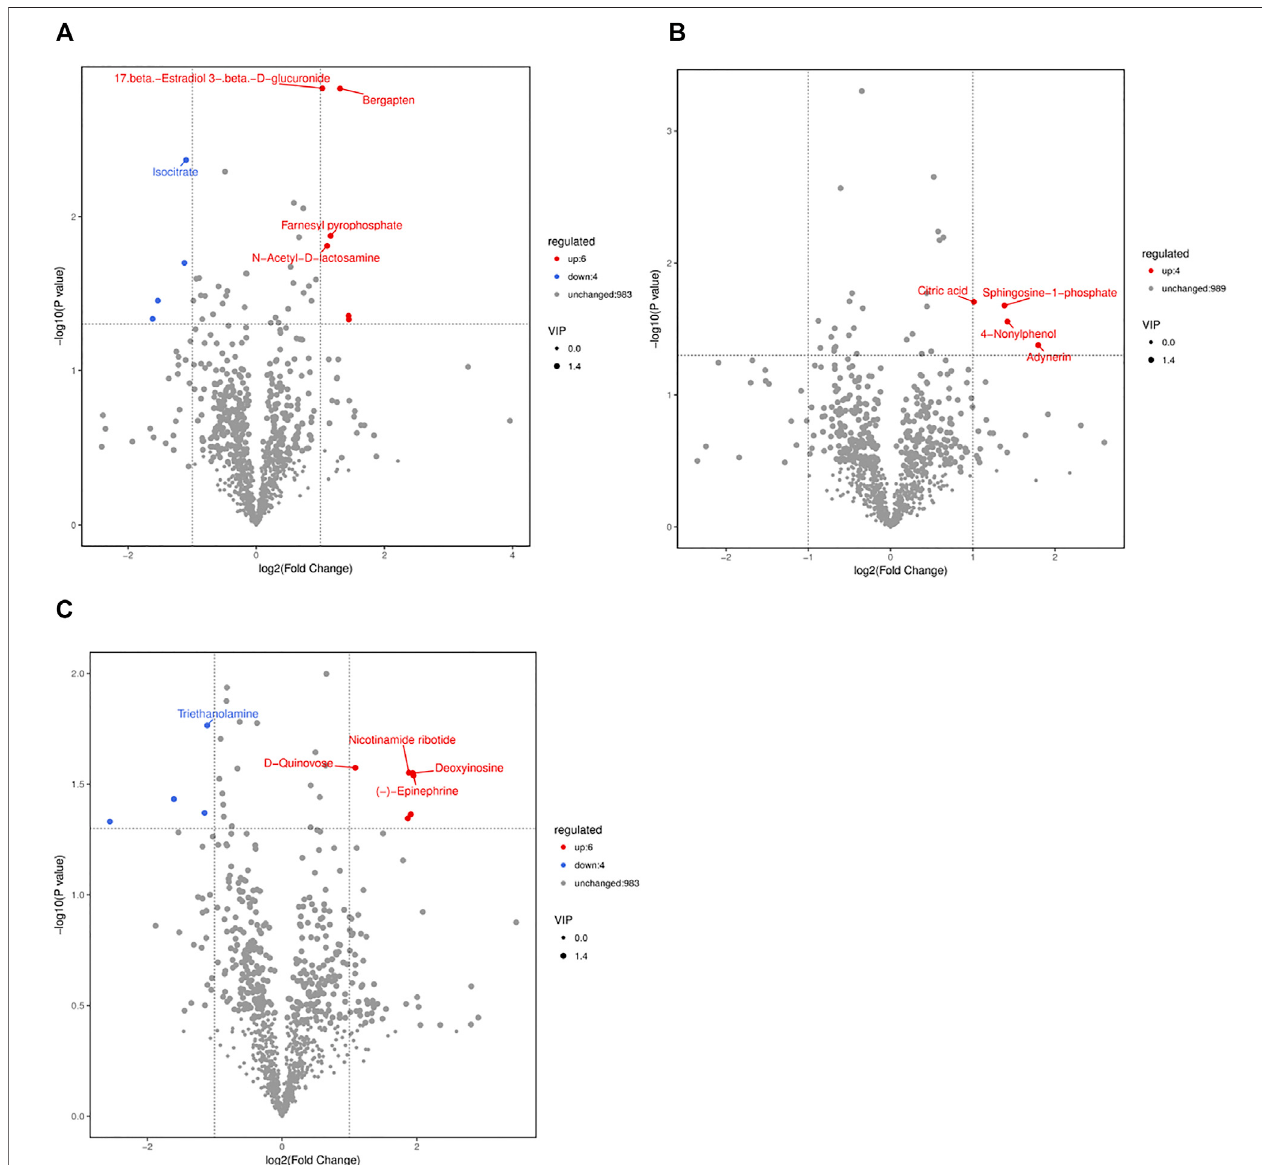
FIGURE3| VolcanoplotsoftheNTandCSgroupsbasedonspectraldatafromtheionmodes (A) ,NT vs CS2; (B) ,NT vs CS6; (C) ,NT vs CS12.Note:onepointin thegraphcorrespondstoametabolite, andthesizeofthepointsrepresents theVIPvalueoftheOPLS-DAmodel.Redindicatesupregulated metabolites,blueindicates downregulated metabolites, black indicates metabolites that were not signi fi cantly different between the CS and NT groups.